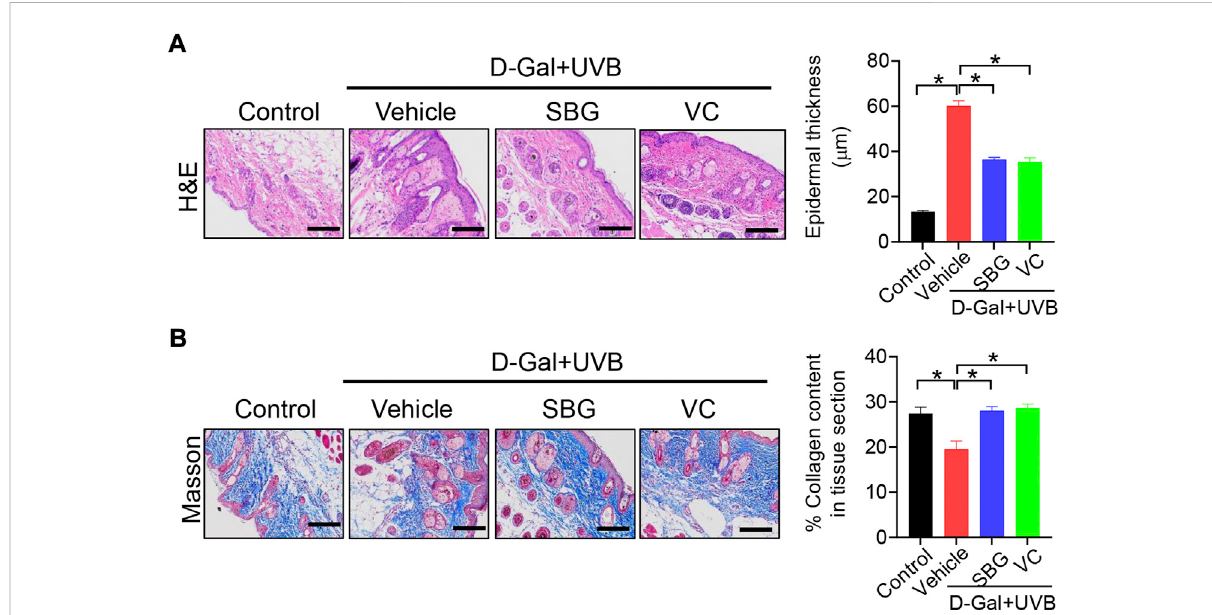
FIGURE 3 Effects of SBG on epidermal thickness and collagen content in aging mice. (A) H&E staining (left panel) and epidermal thickness (right panel) of skin derived from D-gal/UVB-treated and control mice. Scale bar = 100 μ m. (B) Masson staining of the skin derived from D-gal/UVB-treated and control mice. The right panel shows collagen content in the skin. Data are mean ± SD ( n = 7). * p < 0.05 (one-way ANOVA and Bonferroni post hoc test). Scale bar = 100 μ